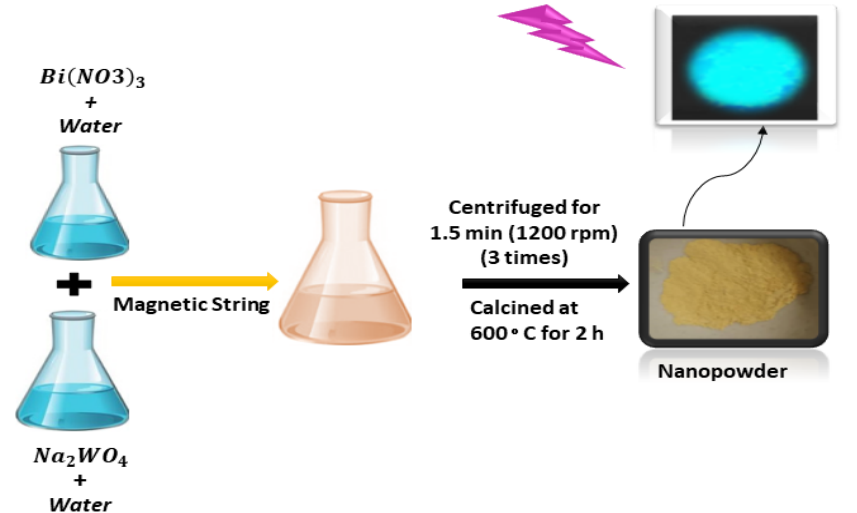
Fig. 1. Brief diagram of experimental works for preparation of Figure 1. Brief diagram of experimental works for preparation of sample